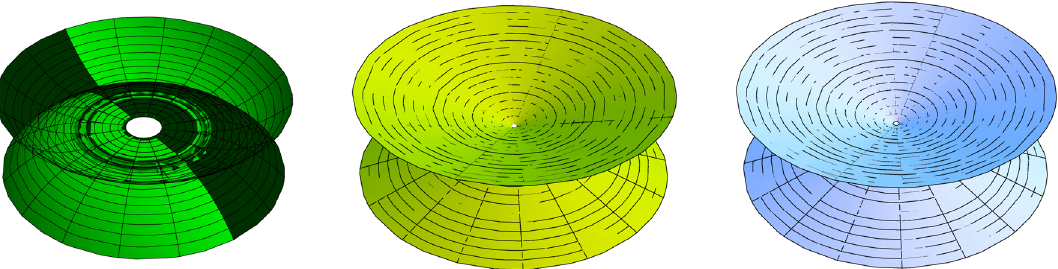
Fig. 5 The figure shows the three dimensional wormhole embedding diagram for the model #1 case ω b = 4 / 5 (left diagram) and γ = 1 (middle diagram) and γ = 2 (right diagram) for model